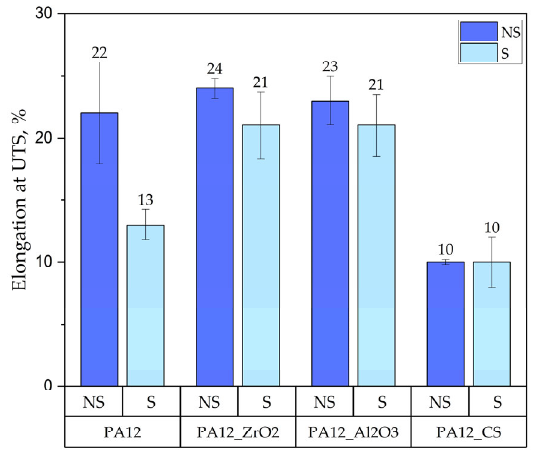
Figure 4. Elongation at ultimate tensile strength of the PA12, PA12_ZrO 2 , PA12_Al 2 O 3 and PA12_CS samples in their non ‐ sterilised/ initial state and after sterilisation.